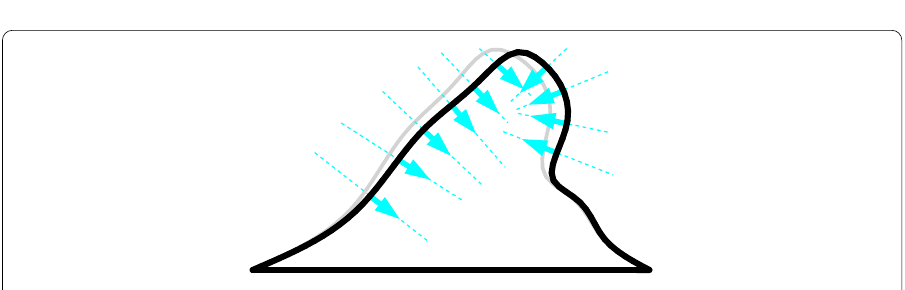
Fig. 3 Measurement points and directions as arrows indicating the positive directions for homogeneous FSI example on the edges of the deformed geometry of the reference result (black) and initial geometry (gray)